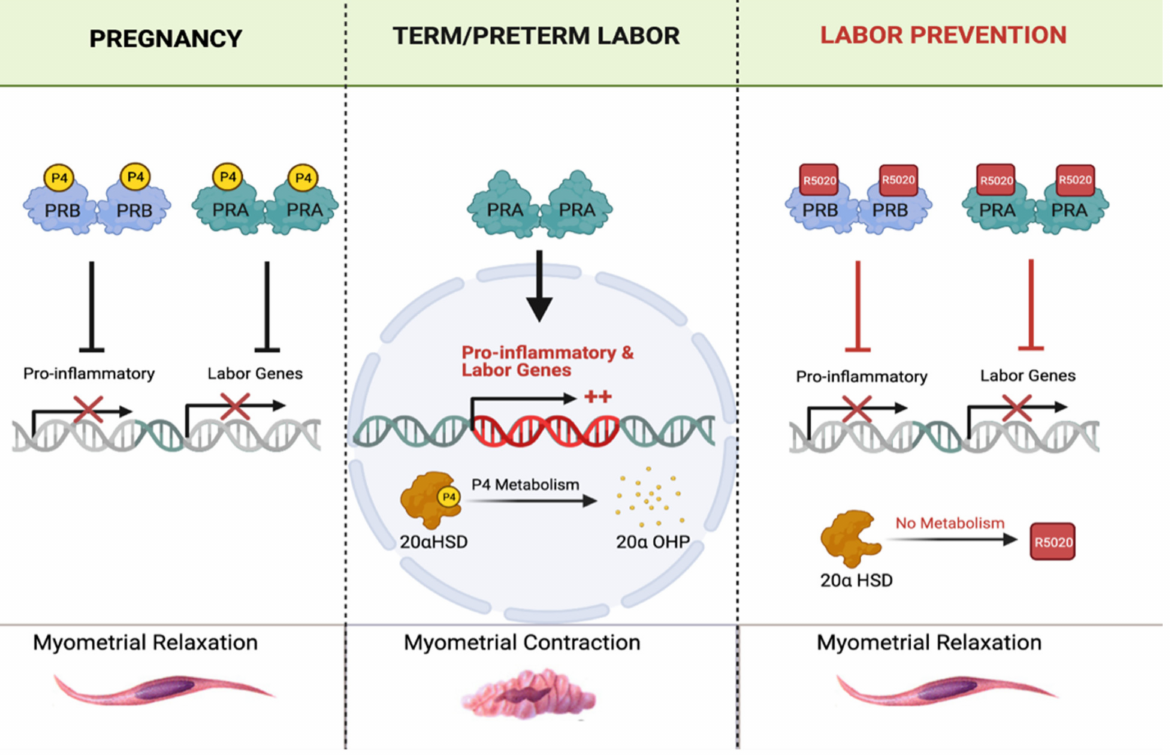
Figure 1. The potential mechanisms of selective P4 receptor modulator action on uterine muscle during pregnancy and term/preterm labor. ( Left panel ) During pregnancy, P4 liganding of P4 receptors (PR-A and PR-B) inhibits pro-inflammatory (cytokines and chemokines) and pro-contractile (CAPs) uterine genes, thereby maintaining myometrial relaxation. ( Middle panel ) During term and preterm labor, myometrial 20 α -hydroxysteroid dehydrogenase (20 α -HSD) enzyme expression and activity is upregulated, which results in local intracellular metabolism of P4 into its PR-inactive metabolite, 20 α - hydroxyprogesterone (20 α OHP). This leads to un-liganding of PRs (unbounding of P4). Un-liganded PR-A activates myometrial expression of pro-inflammatory and pro-contractile genes (i.e., oxtr and gja1 ) and induces labor contractions. ( Right panel ) Administration of SPRM compounds such as R5020 (aka: Promegestone), which is not a substrate for 20 α -HSD, has higher affinity for PRs, longer half-life than P4, keeps the PRs constitutively liganded, maintains uterine quiescence, and prevents labor contractions. Note: this figure was created with